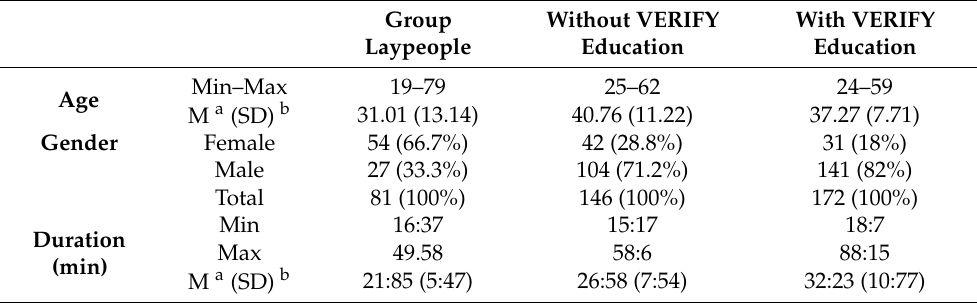
Table 1. Sociodemographics and duration in minutes and seconds for completing the rating by groups.